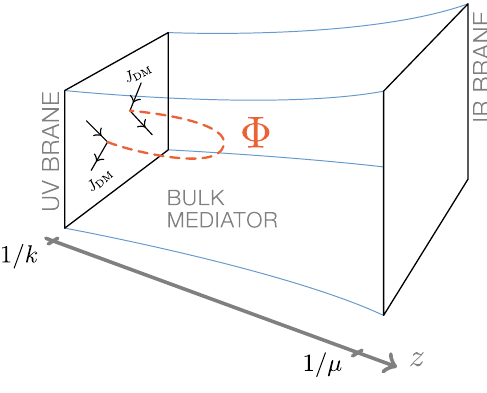
Figure 1 . Schematic description of the continuum-mediated self-interacting dark matter scenario.